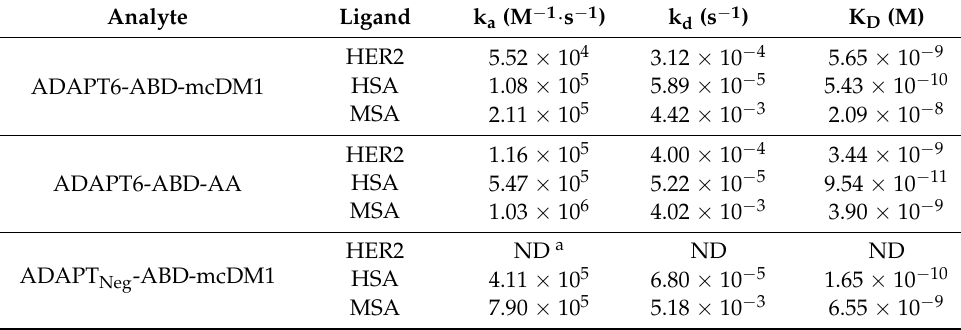
Table 1. Kinetic parameters and equilibrium dissociation constants.